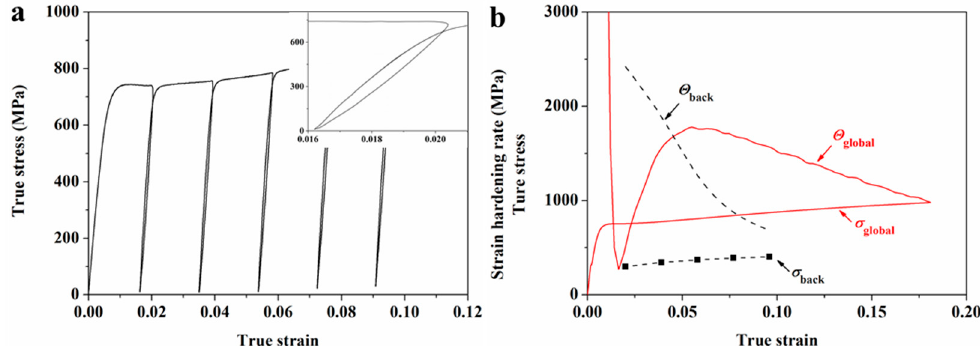
Figure 6. ( a ) The tensile loading-unloading-reloading (LUR) true stress-strain curve of the 700 °C annealed sample; ( b ) Back stress and its strain hardening.